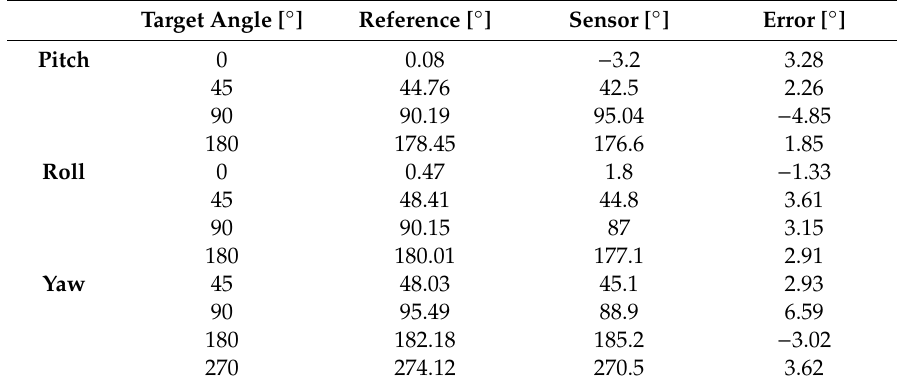
Table 2. Result of pitch, roll, and yaw static measurements with their respective error at di ff erent